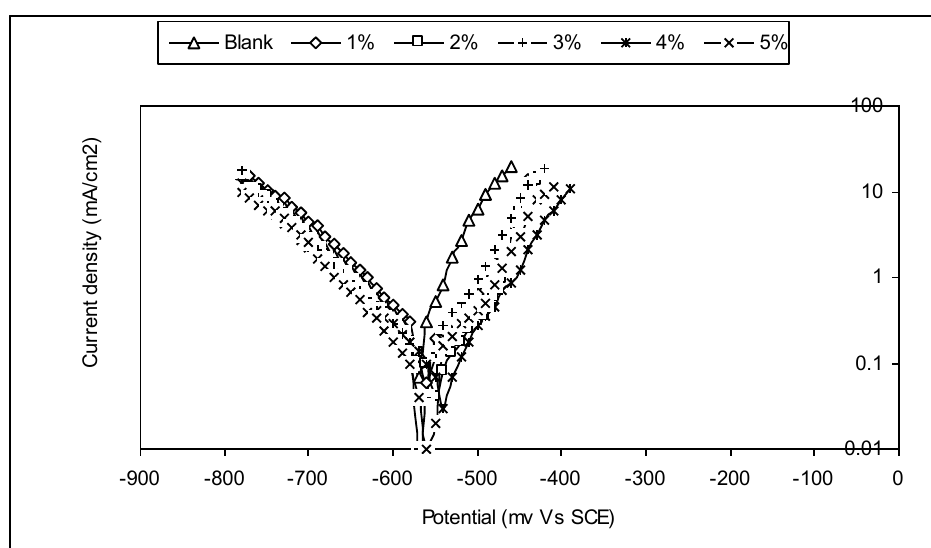
Figure 5. Typical Potentiostatic curves for mild steel in 2N Sulphuric acid with